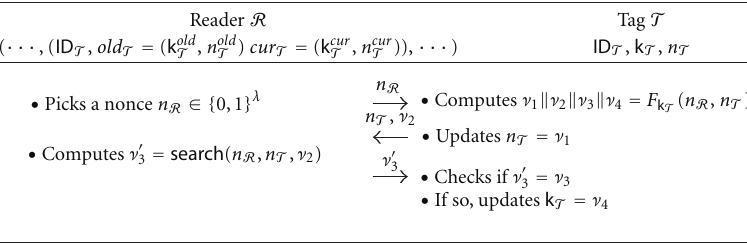
F 4: O-FRAP authentication protocol.